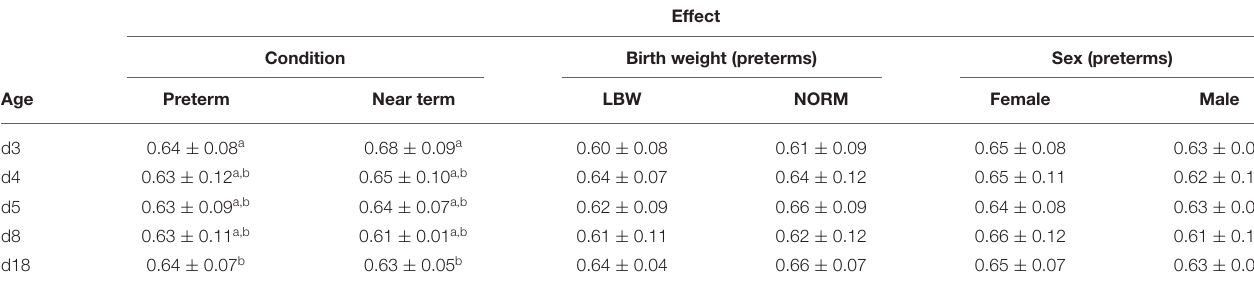
TABLE 4 | Duty factor ( Df ) (mean SD; m) according to gestational age when cesarean-section derived (condition) (preterm at gestational age 106 days—term at ± gestation age 115 days) and postnatal age (3, 4, 5, 8, and 18 days), birth weight (low birth weight (LBW): 0–25th percentile—normal birth weight (NORM): 50–75th percentile), and sex (female vs.